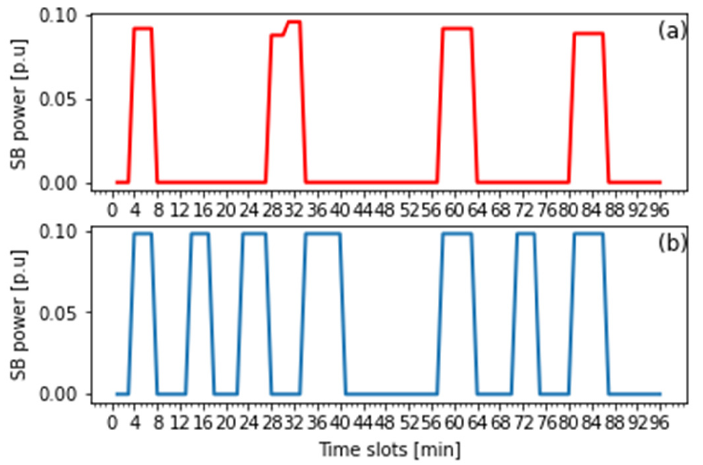
Figure 9. Effect of voltage-based DR on SB’s charge/discharge power: ( a ) with voltage-based DB; ( b ) without voltage-based DR.